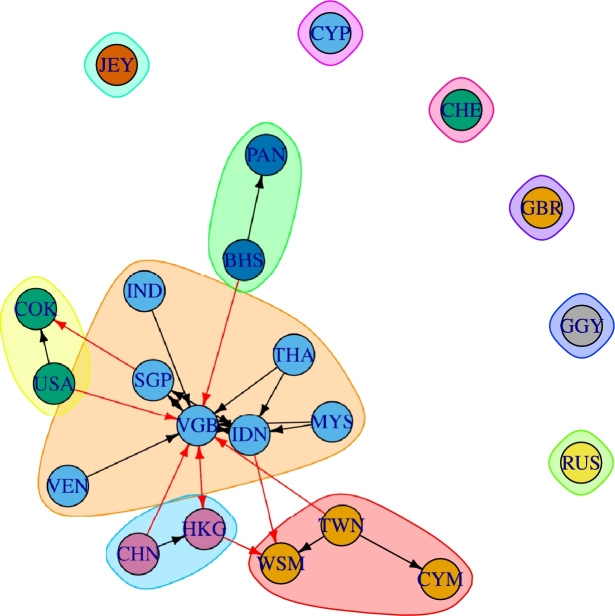
Network structure and clusters for top countries in the database. See acronyms of countries in Table 2.